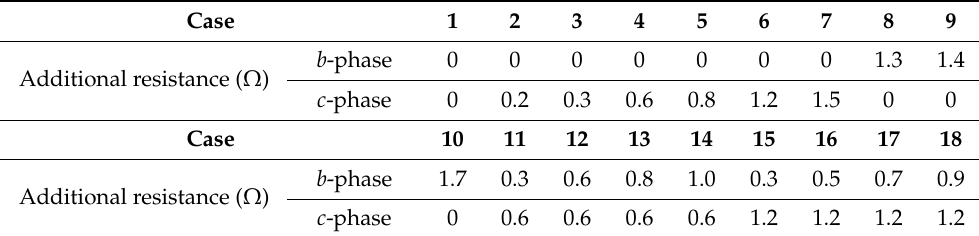
Table 2. HRC conditions of cases tested in the experiment.